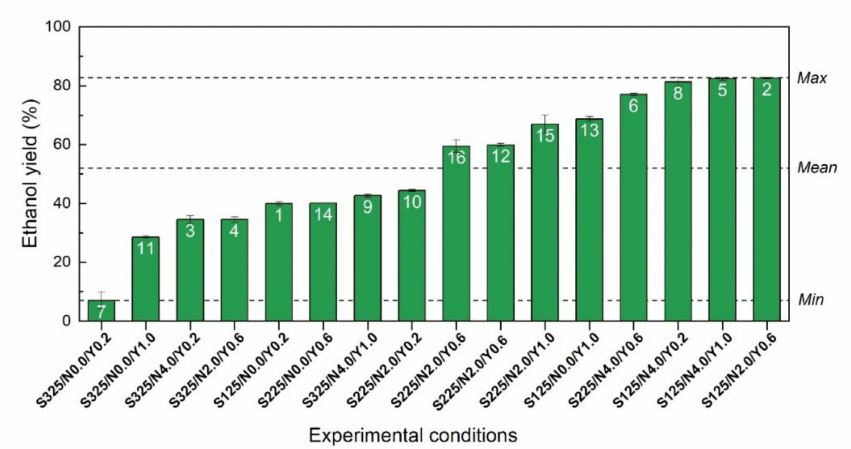
Figure 3. Ethanol yields expressed as a percentage of the maximum theoretical ethanol concentration for all the investigated runs of the CCD-RSM (white label). Yields were sorted in ascending order for a better interpretation of the ethanol performances. Dashed lines show the lowest (Min), the highest (Max) and the average (Mean) ethanol